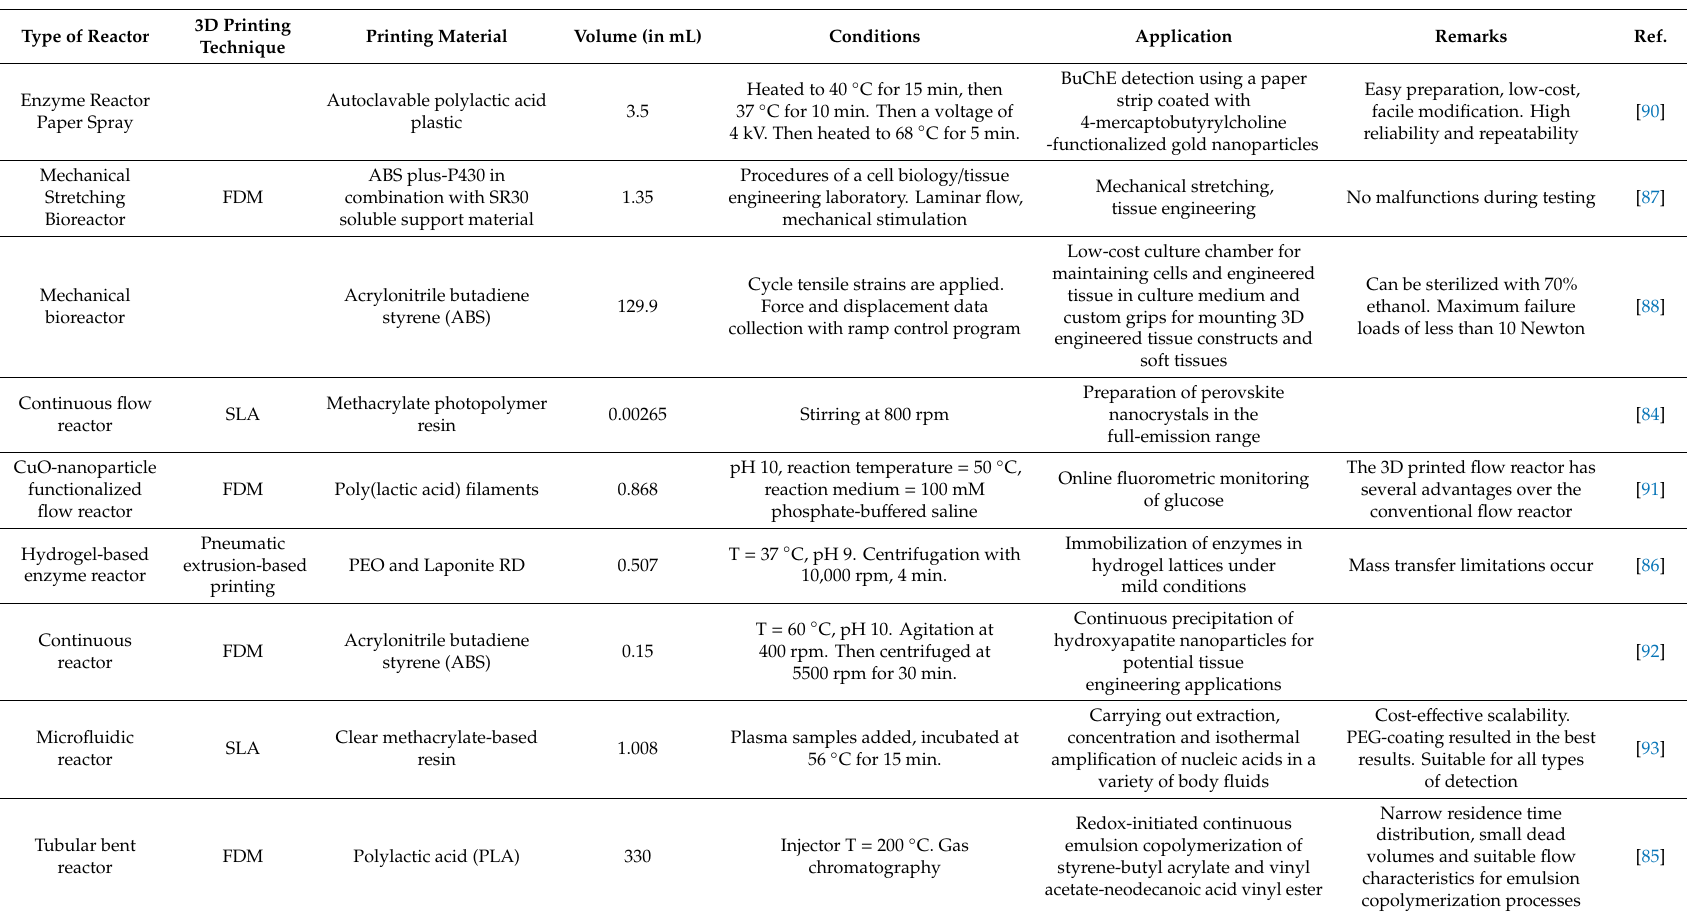
Table 3. 3D printed (bio)reactors and their